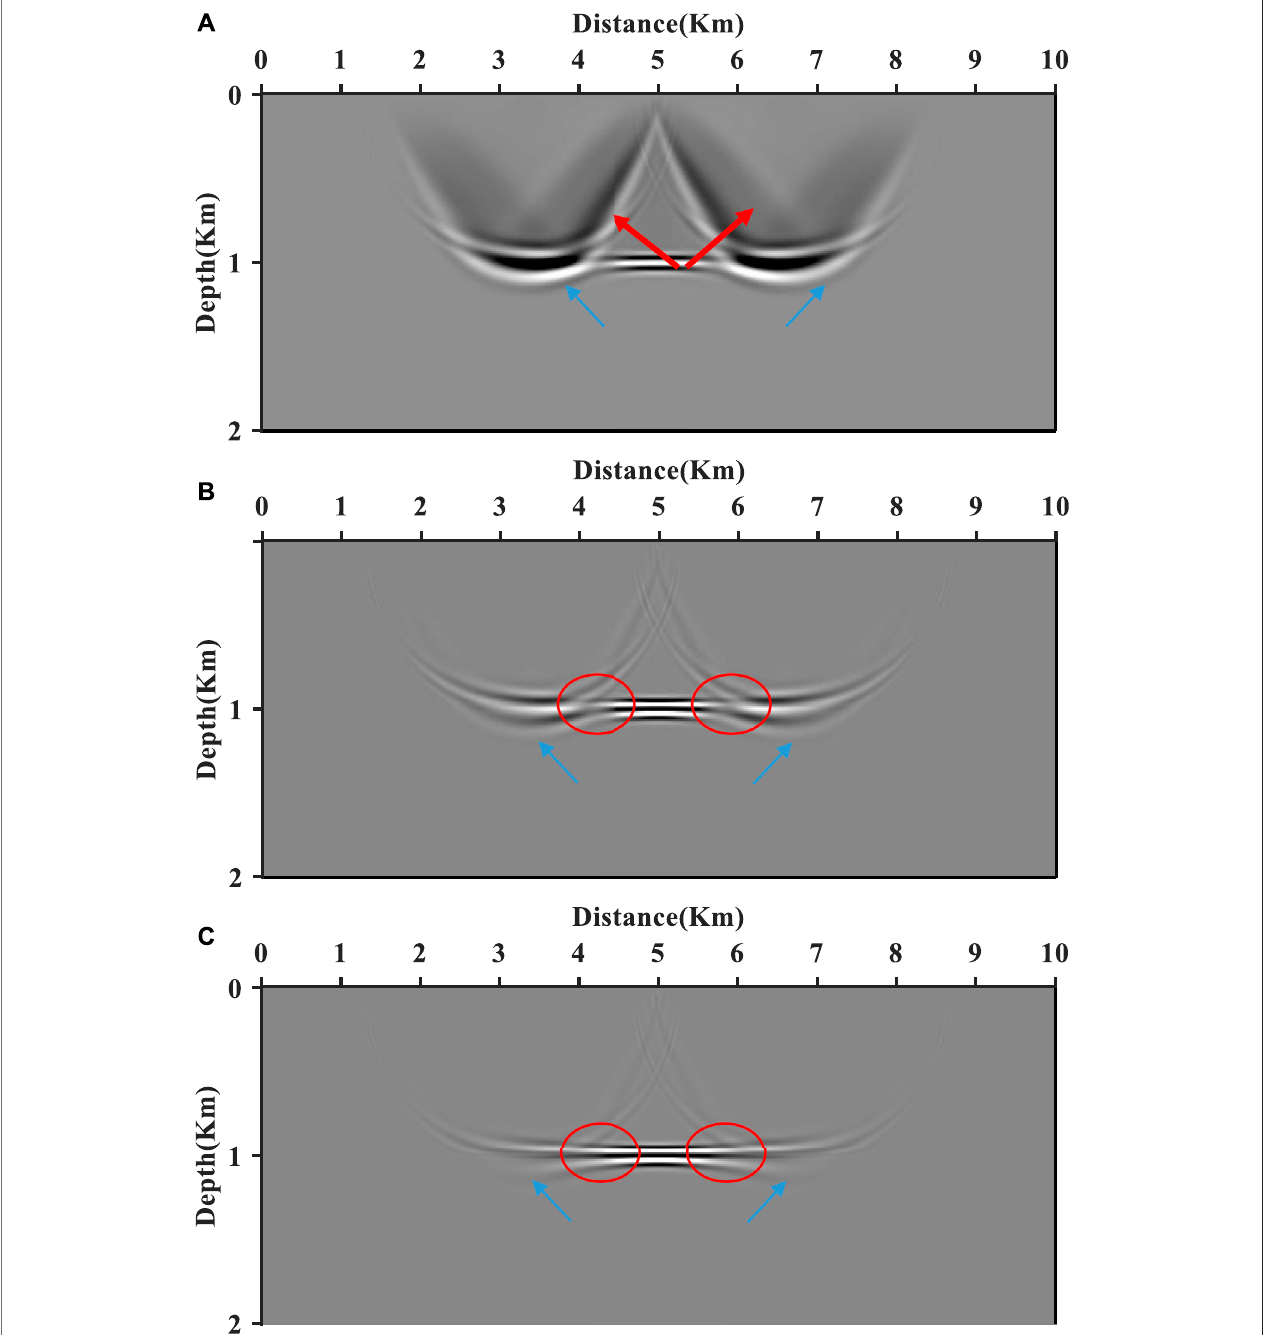
FIGURE9| PPmigrated images ofthetwo-layer fl at model bythescalar imagingcondition (A) , thescalar imagingcondition withaLaplace fi lter (B) , and thescalar imaging condition with a pseudo-Laplace fi lter (C) . The backscattering noise (marked by the red arrow) has been effectively suppressed in PP images by scalar imaging conditionswithaLaplace fi lterand apseudo-Laplace fi lter.Furthermore,the polarityreversal(markedbythered circle)has beencorrectedin thePPimage bythescalar imaging condition with a pseudo-Laplace fi lter.